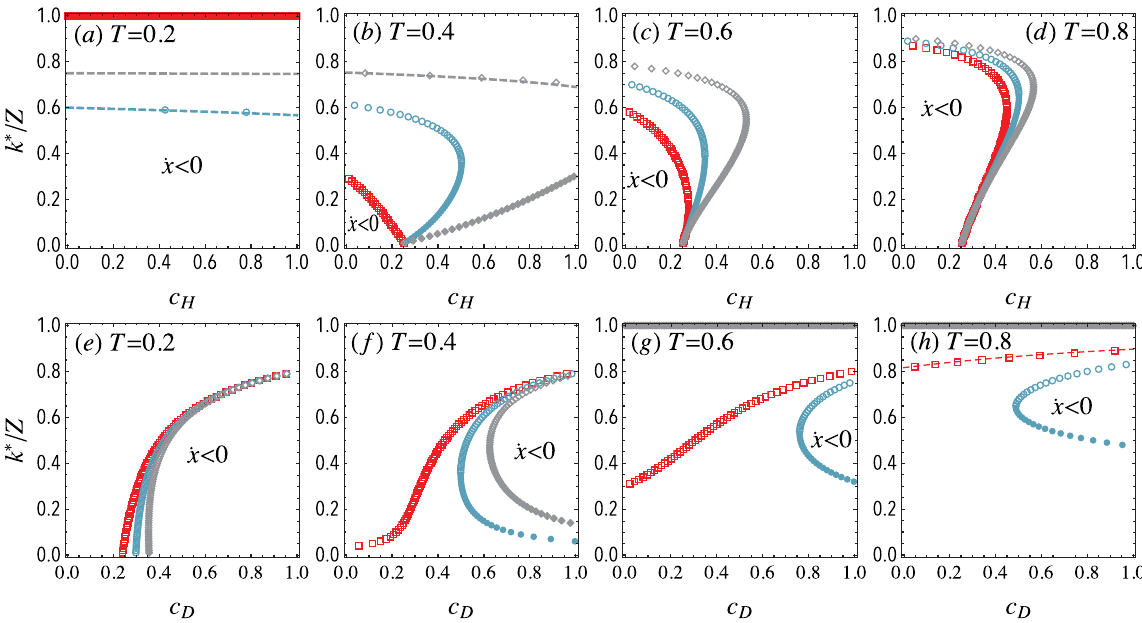
Figure 5. Equilibria of the N-person Hawk-Dove Game with threshold in finite populations. Fraction of doves k * / Z in the equilibrium as a function of the hawks’ cost c H (top) and doves’ cost c D (bottom), for a sample size of N = 5 in a finite population of size Z = 100. Solid (dashed) points represent stable (bistable) points, whereas dashed lines mark the regions beyond which f D > f H and below which f D < f H . In top panels, different colored symbols represent different doves’ costs: red, blue and gray lines correspond to c D = 0.2, 0.5, 0.8, respectively. In the bottom panels, red, blue and gray symbols represent hawks’ costs c H = 0.2, 0.5, 0.8, respectively. Other parameters are R = 1, w =